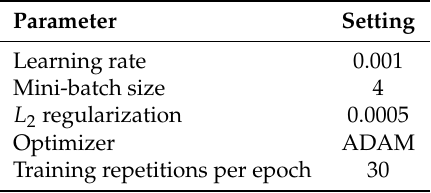
Table 2. Parameters and